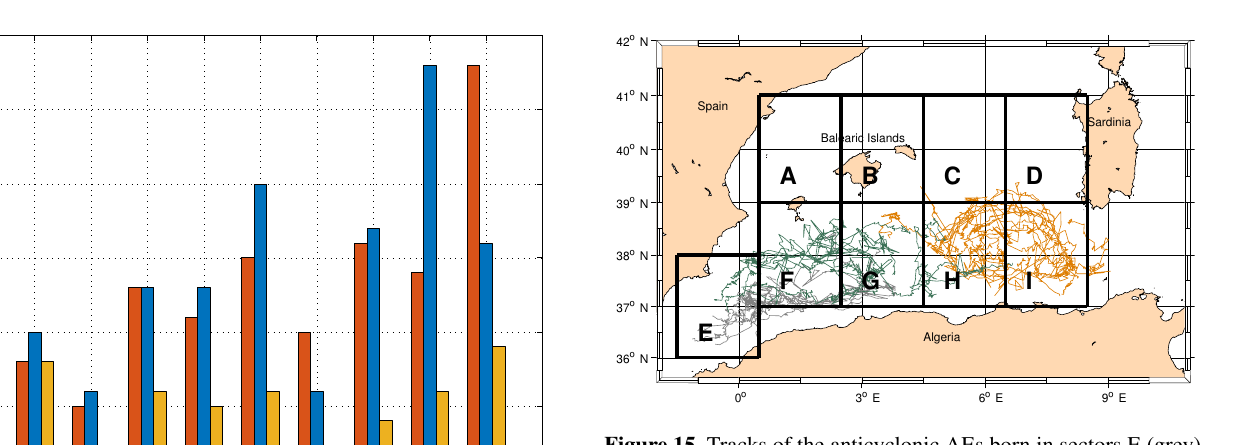
Figure 15. Tracks of the anticyclonic AEs born in sectors E (grey), G (green) and I (orange). The eddies formed west of 3.5 ◦ (sec- tor G) move mainly westward, following the western cyclonic gyre (Fig. 18), while structures formed east of 3.5 ◦ move eastward along the Algerian Current.